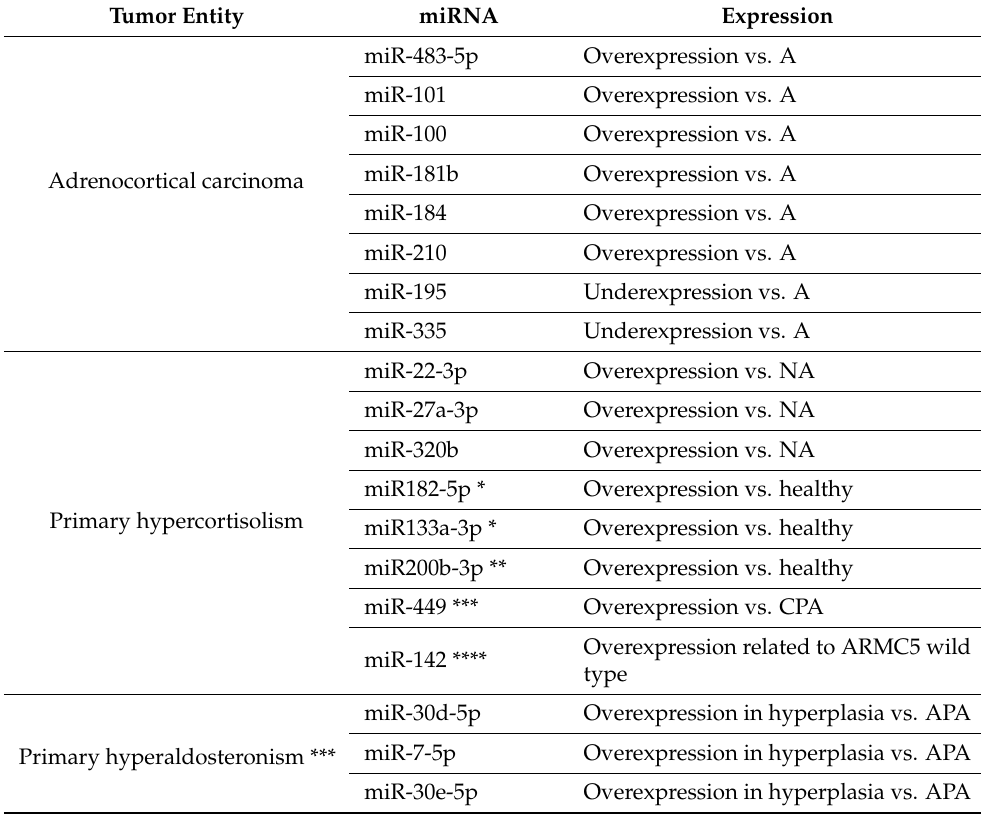
Table 1. Circulating miRNA in adrenocortical